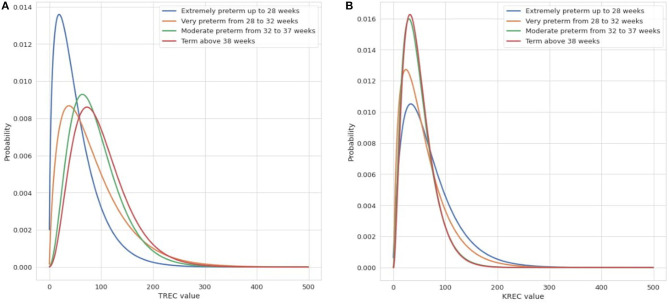
The distribution of TREC copies/μL (A) and KREC copies/μL (B) in groups divided by GA. The fitted beta distributions of TREC (copies/μL) and KREC (copies/μL) values in four study groups: extremely preterm (blue line), very preterm (orange line), moderate preterm (green line), term newborn (red line).